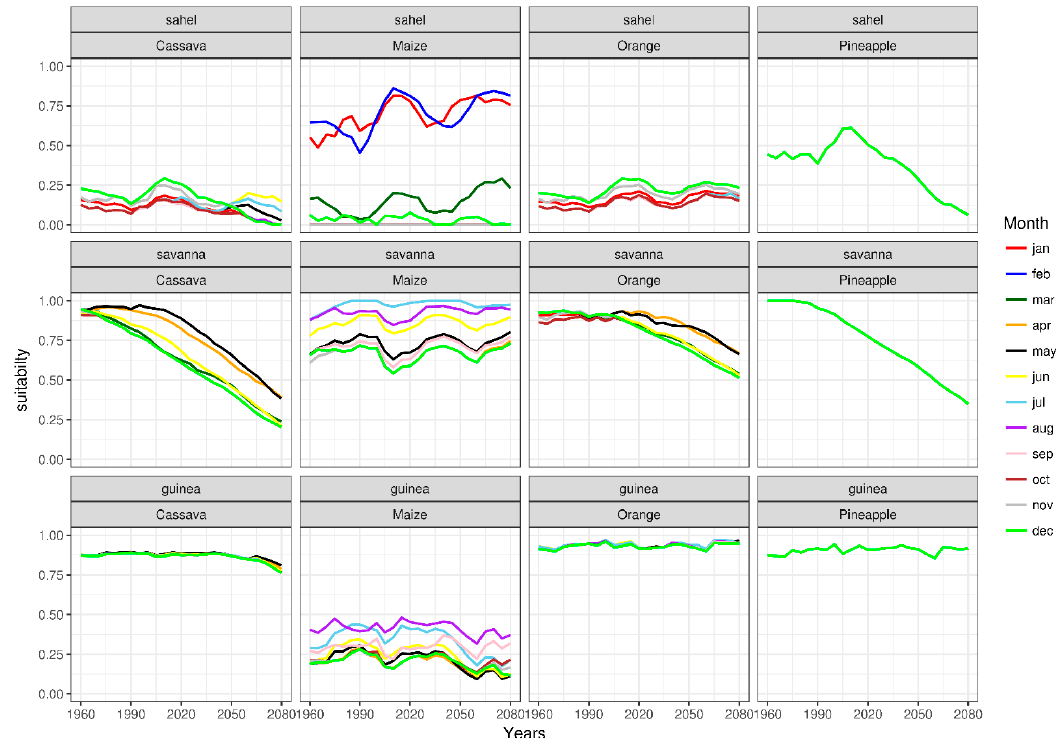
Figure 7. Projected model ensemble suitability over West Africa between 1960–2100 for cassava, maize, orange, and pineapple. The Ecocrop simulations of crop growth suitability for the period